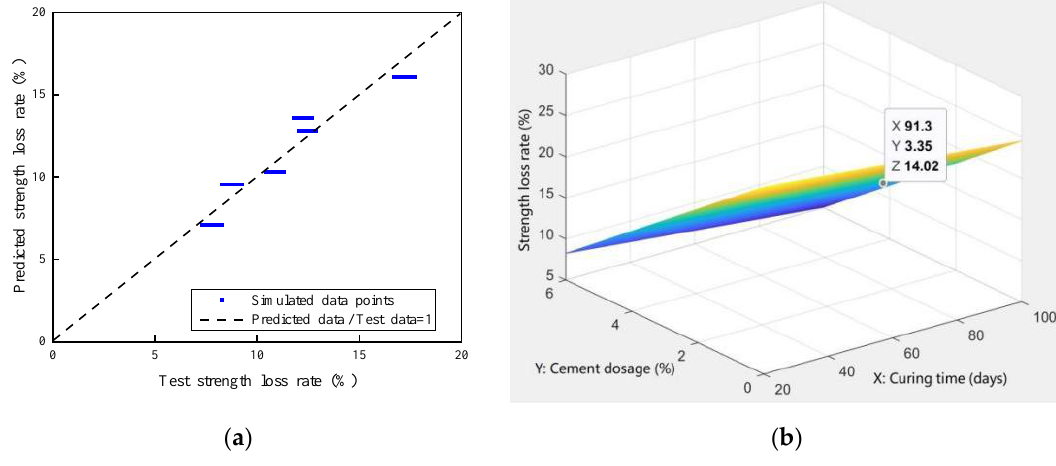
Figure 24. Numerical simulation of compressive-strength-loss rate: ( a ) Monte Carlo simulation; ( b ) 3D diagram of nonlinear strength-loss fitting equation.